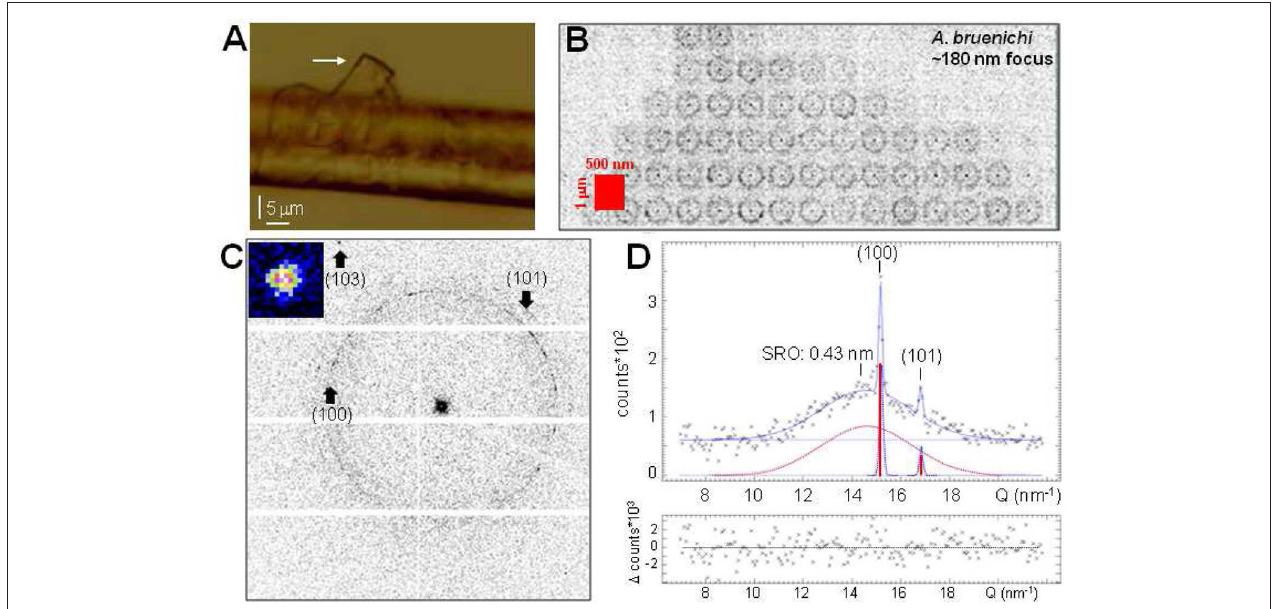
FIGURE 4 | Polyglycine-II (PG-II) nanocrystallites in MaS skin-layer. (A) Optical microscopy of thin layer (white arrow) detaching from A. bruennichi’s MaS thread’s surface. (B) WAXS composite image based on 500 nm hor × 1 µ m ver raster-steps (red rectangle) from the tip of the layer in (A) through a 190 hor × 170 ver nm 2 (fwhm) focus. The pixels are 16 × binned to enhance weak scattering. (C) Average of patterns from the composite image; positions of (100)/(101) PG-II reflections indicated. A (103) peak with d = 0.254nm (zoom) is indicated at the edge. The limited amount of higher order PG-II reflections is due to the preferred [001] texture, reducing the probability of Bragg scattering. (D) Radial intensity profile of (C) . Gaussians fitted to Bragg peaks (dotted-blue) and SRO scattering (dotted-red); 0-order polynomial fitted to random background. The calculated intensities of the PG-II (100)/(101) Bragg peaks ( Crick and Rich, 1955) are indicated as red bars, scaled to the height of the (100)